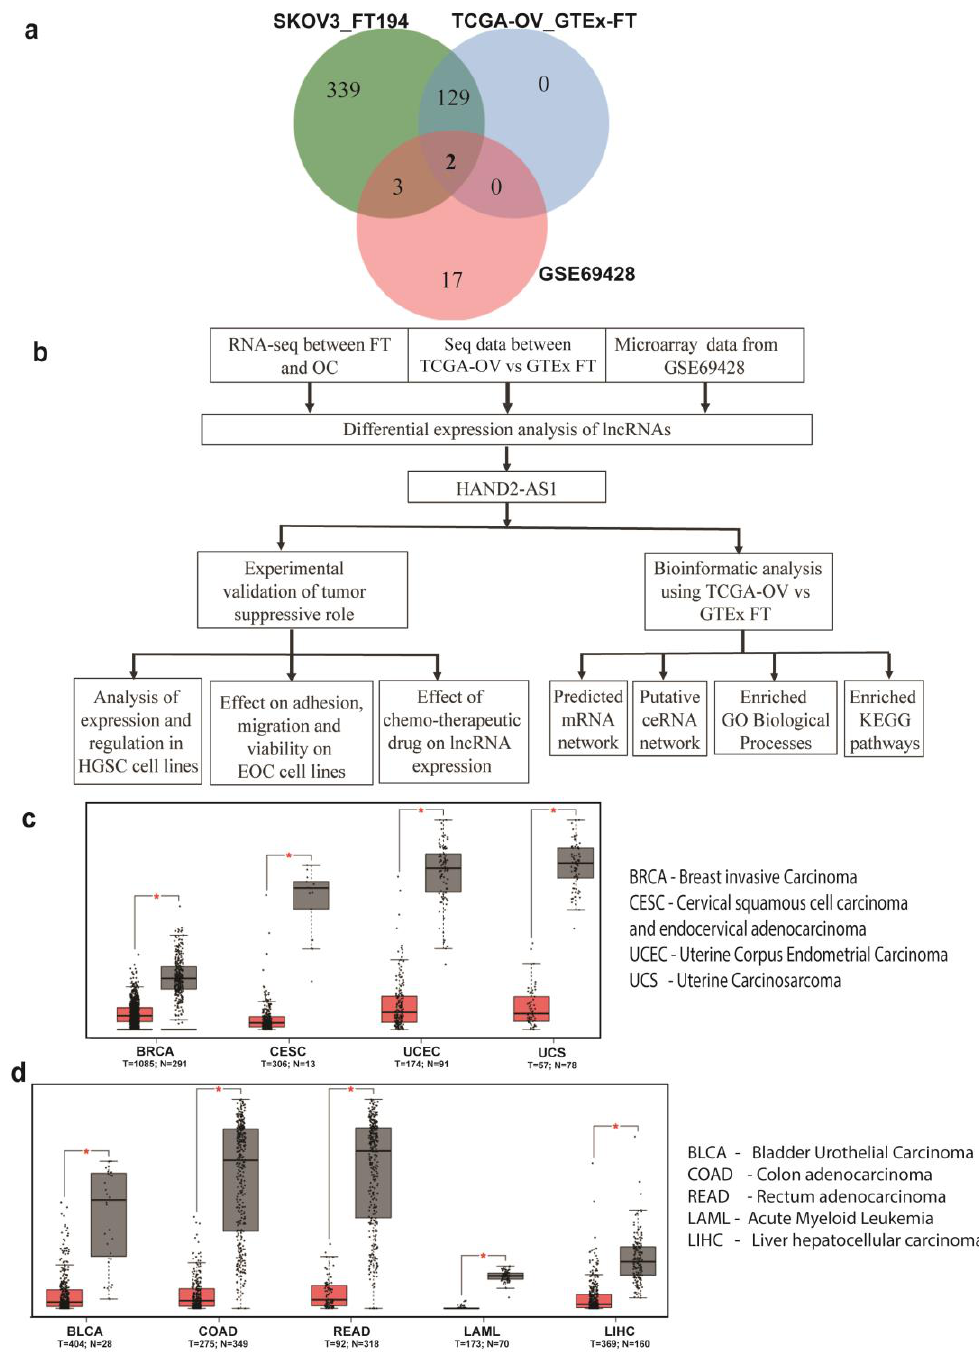
Figure 1. ( a ) Venn diagram showing the distribution of significantly differentially expressed long non-coding RNAs from transcriptome analysis between high-grade serous ovarian carcinoma (HGSC) and fallopian tube (FT) samples; ( b ) Schematic representation of the flow of analysis used to analyze HAND2 Anti sense RNA 1 (HAND2-AS1) in this study; Expression of HAND2-AS1 in ( c ) gynecological cancers; and ( d ) other cancers obtained from The Cancer Genome Atlas (TCGA) using Gene Expression Profiling Interactive Analysis (GEPIA) (between tumor (red) and normal (grey)